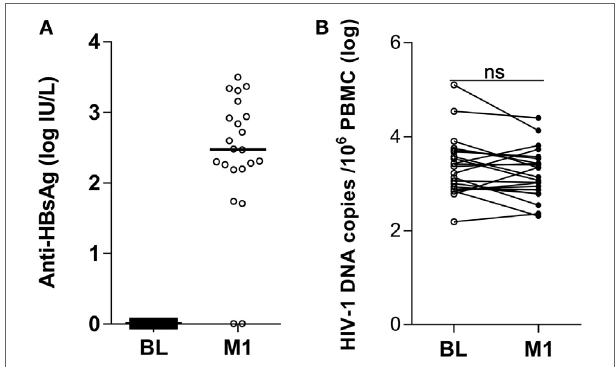
FigUre 1 | Antibody titers to hepatitis B virus vaccine and HIV-1 DNA copies in peripheral blood mononuclear cells (PBMCs) of HIV-1-infected children pre-vaccination and postvaccination. Antibodies to the HBsAg were detected in plasma (a) and HIV-1 DNA copies/10 6 PBMCs were measured in PBMCs (B) from 22 HIV-1-infected children pre-vaccination and at 1 month postvaccination. ns, not significant; BL, baseline; M1, month